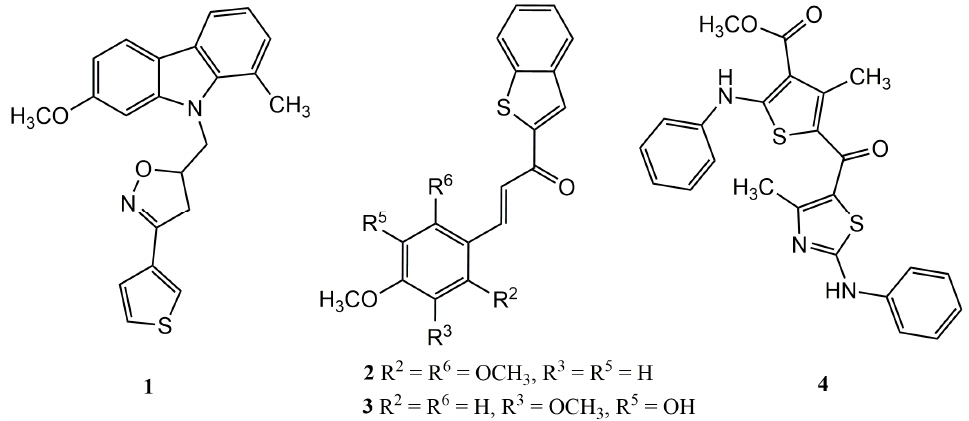
Figure 3. Chemical structures of thiophene-based compounds active against COX and LOX enzymes.